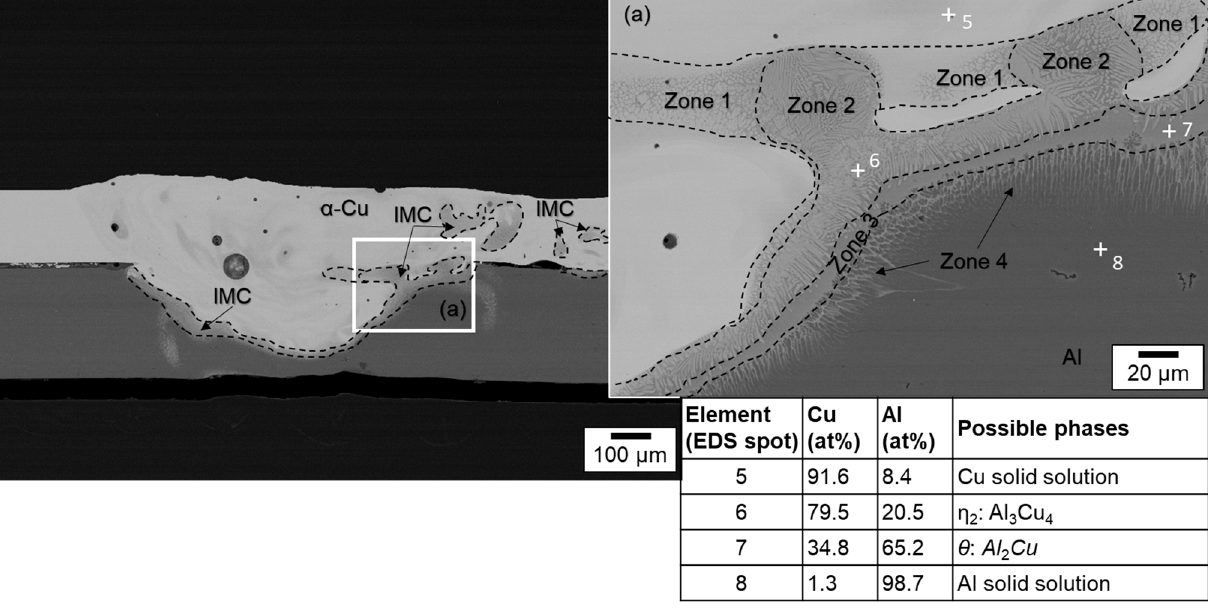
Figure 16. SEM image and EDS scanning spots in the weld seam of the sample produced with pa- rameter set #4; white insert (a) indicates the area of the displayed detail image (a); dashed line indi- cates intermetallic phases ( top ); EDS phase composition at selected scanning spots ( right bottom ).